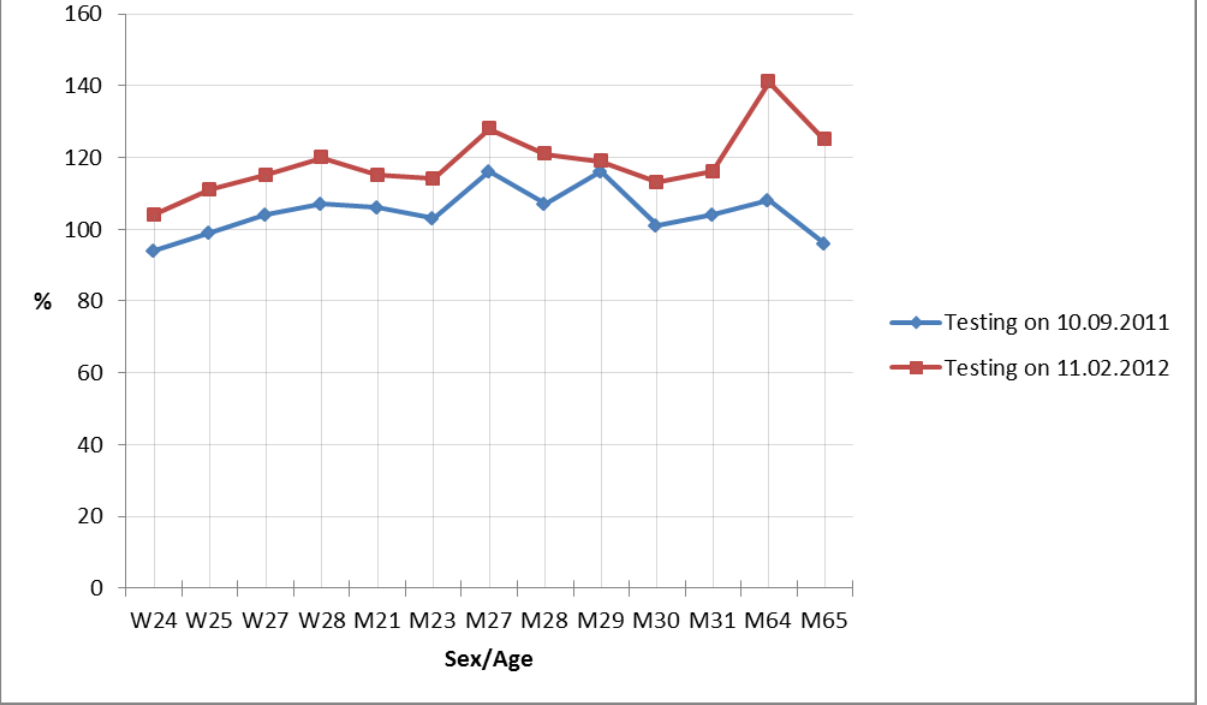
Pic.1 Participants of the experimental group’s dynamics of change of the «Quantity of